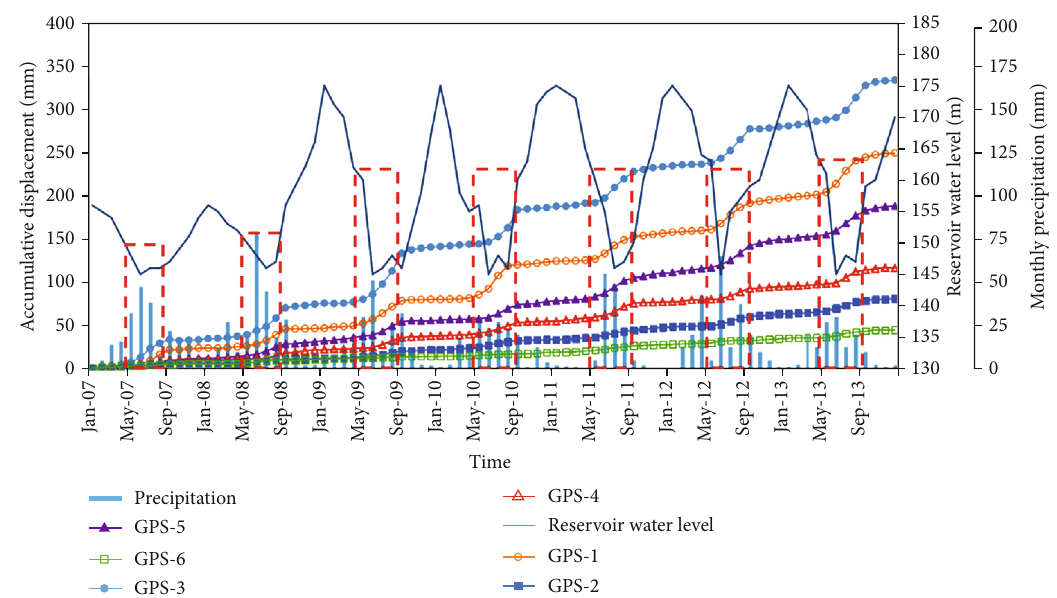
Figure 2: Changes of the accumulative displacement as reservoir water level and precipitation in the Erdaohe landslide.